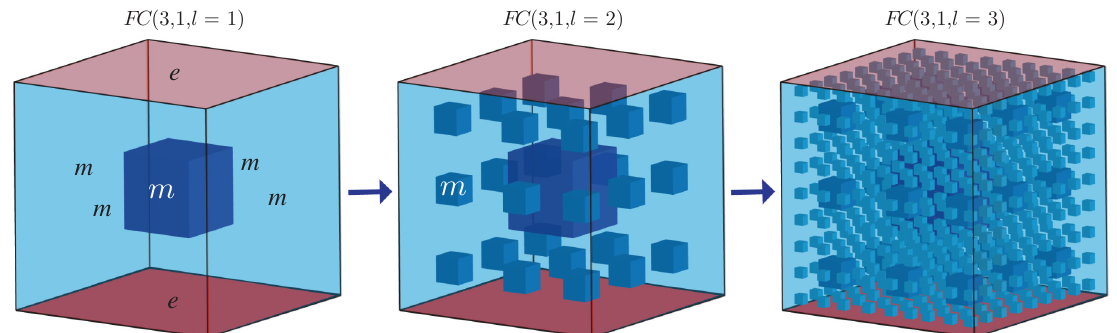
FIG. 15. A 3D fractal surface code defined on the fractal-cube geometry FC ( 3, 1 ) (at levels l = 1, 2, and 3). The illustrated model contains only m -holes (blue). The outer boundaries are the same as those of the 3D surface codes, with the top and bottom faces being e -boundaries, while the rest are m -boundaries.